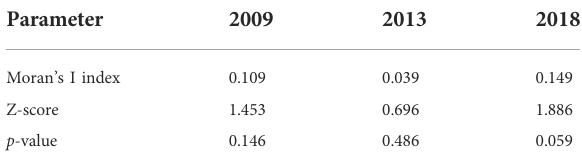
TABLE 7 Spatial autocorrelation of residual error.